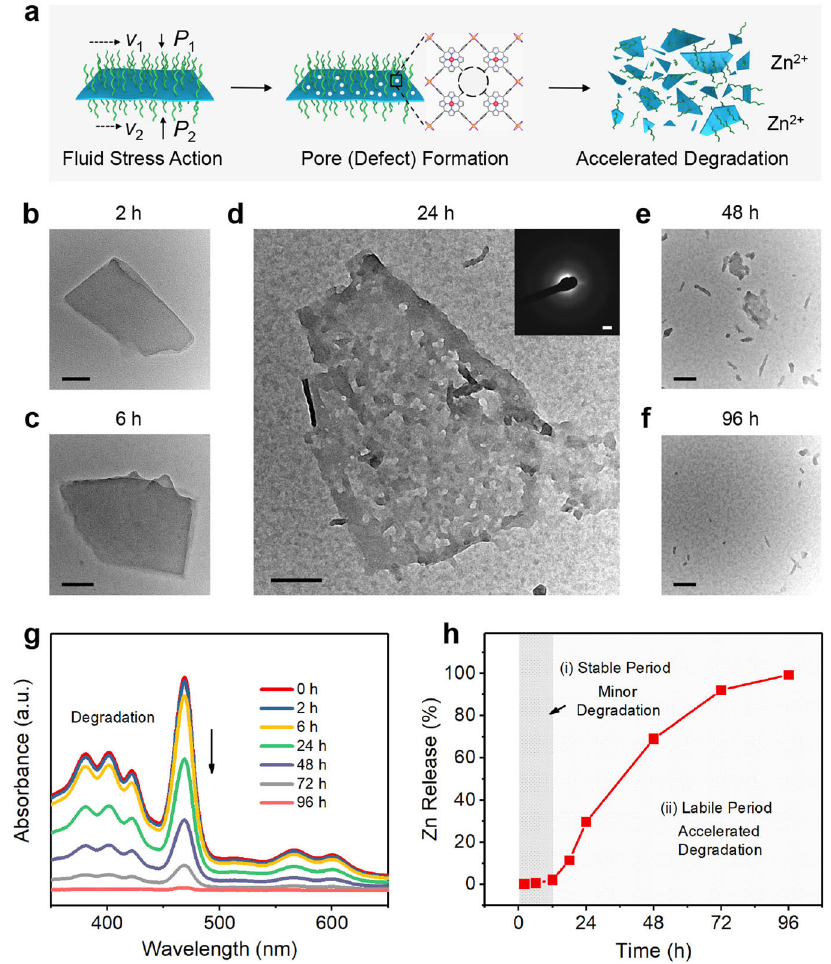
Fig. 4 Long-term degradability of ZMTP nanosheets in response to fl uid stress. a Scheme for the degradation process of ZMTP nanosheets during a long time period. The different fl uid fl ow velocities on the two planar surfaces of a nanosheet in solution create differential fl uid stress perpendicular to the two sides of the nanosheet, resulting in the axial weak deformation of the thin nanosheet and subsequent formation of pores. These structural defects will further promote the degradation of the whole nanosheets and the release of Zn 2 + . b – f TEM images of ZMTP nanosheets after degradation in mild